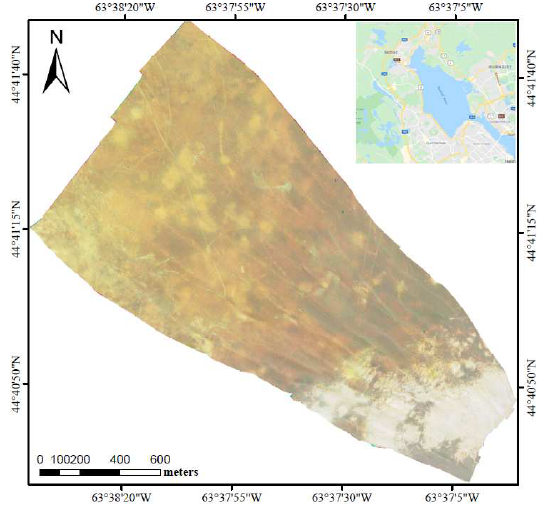
Figure 2. Bedford Basin 2017 Dataset. A pseudocolor is presented from the combination of 100 kHz, 200 kHz and 400 kHz backscatter layers.